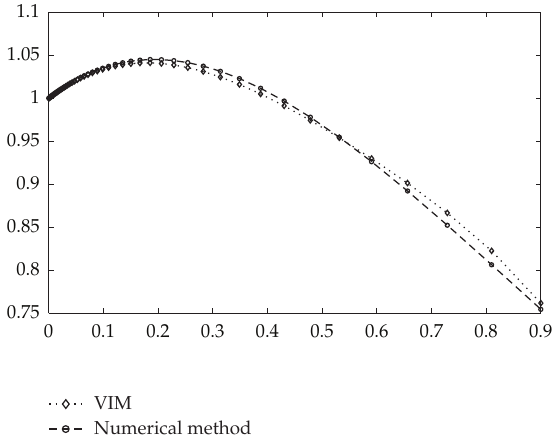
Figure 3: Time response for x ΔΔ (cid:10) (cid:7) 2 . 5 (cid:10) 0 . 1 x (cid:8) x Δ (cid:10) x (cid:10) x 2 (cid:6) 0 with 3 iterations.